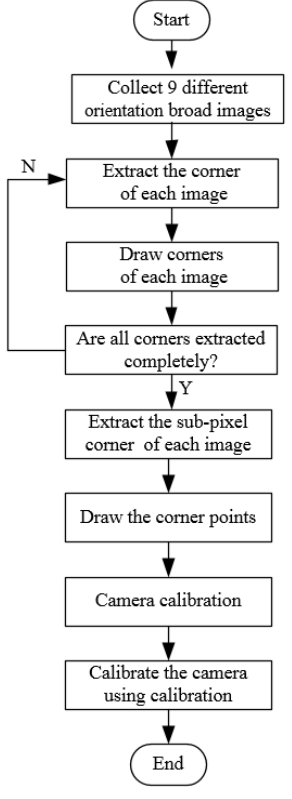
Figure 4. Flow chart of camera calibration.